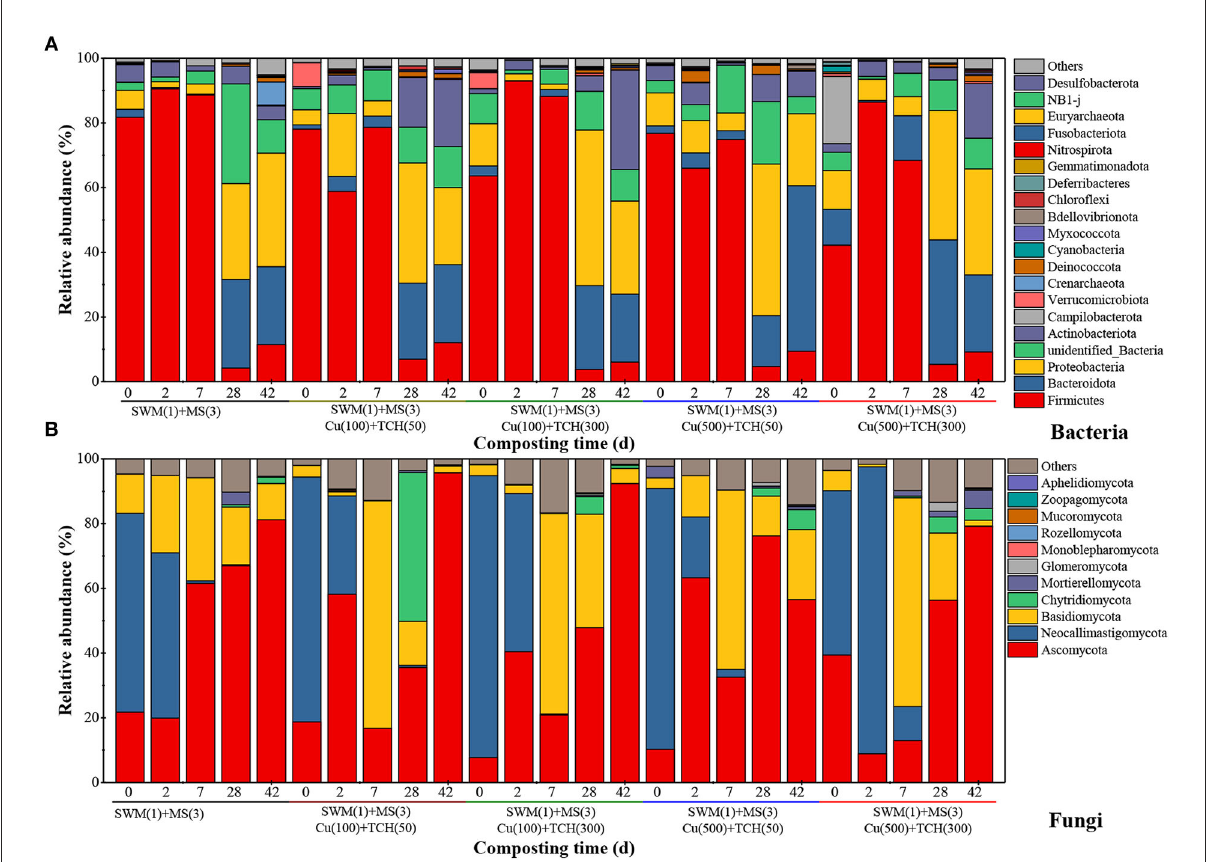
FIGURE5 Dynamic changes in the bacterial (A) and fungal (B) communities at the phylum level during the composting process.